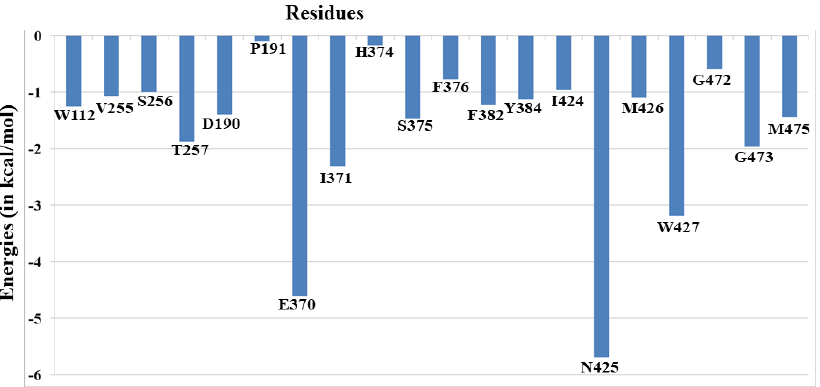
Figure 4. The residue interaction map for NBD with gp120 for the most populated trajectories of 100 ns.